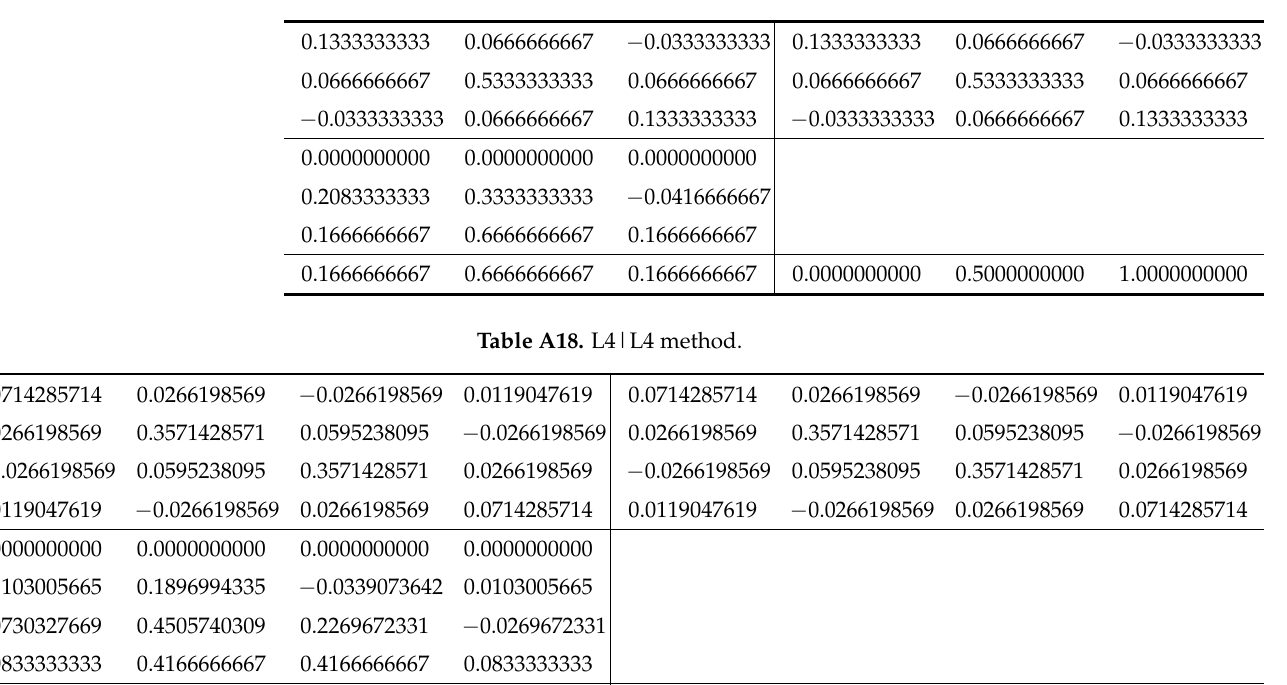
Table A17. L3|L3 method.